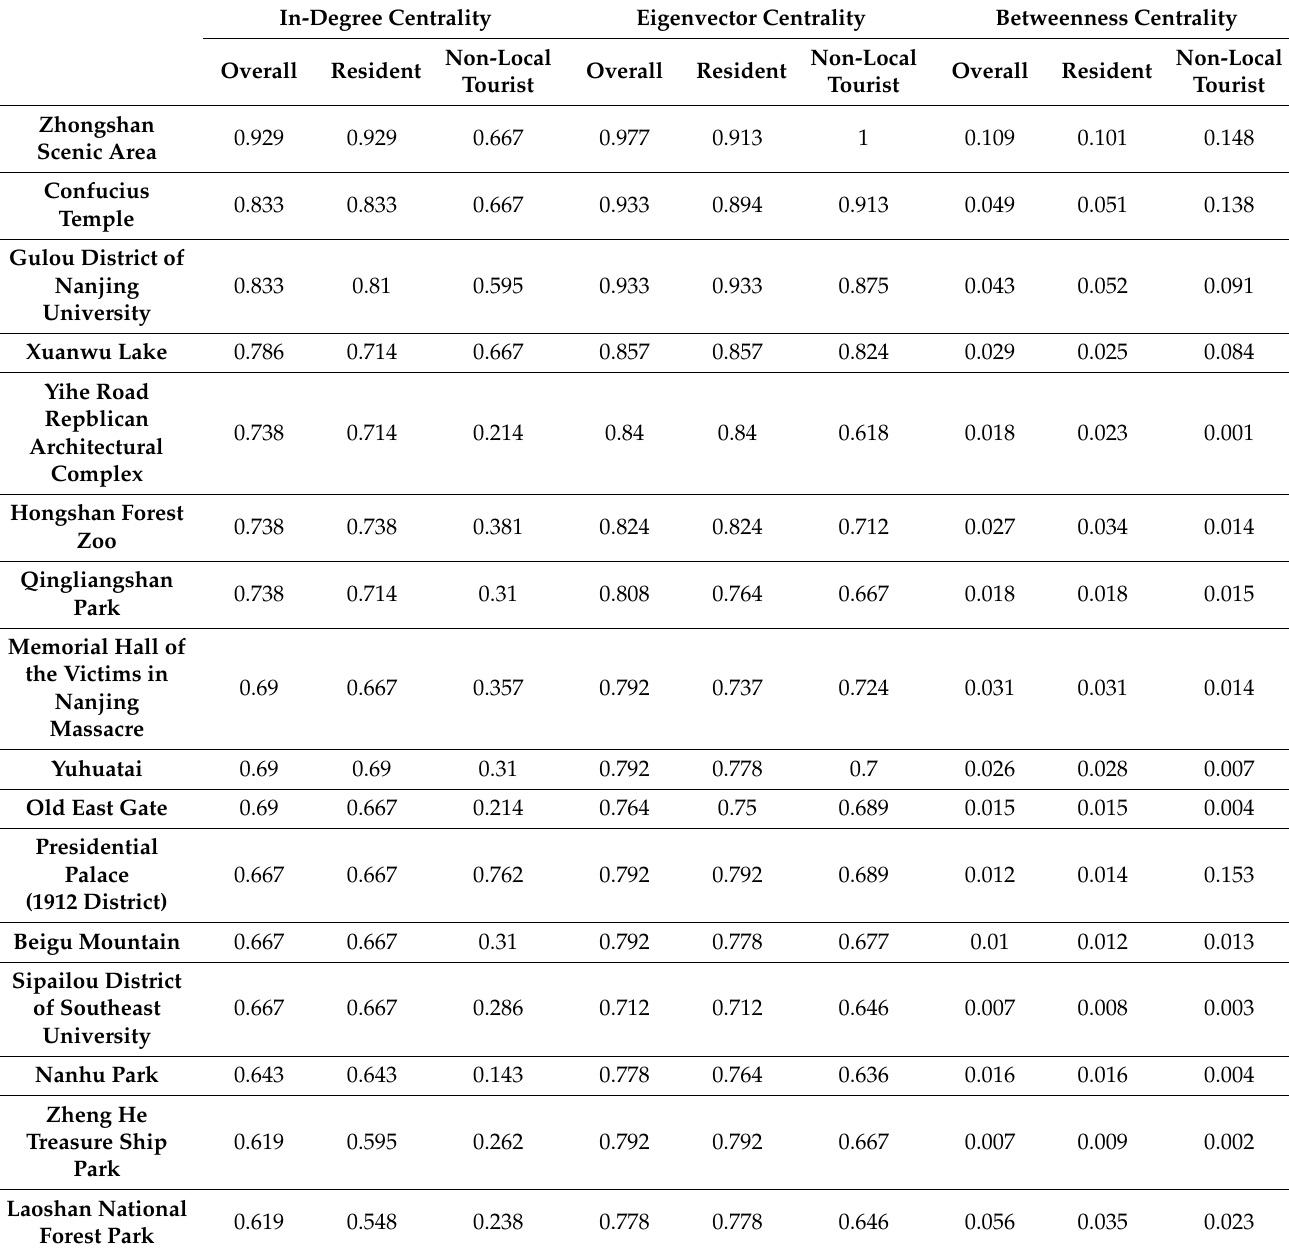
Table 2. Tabulation of three types of node centrality in the tourism flow network. In-Degree Centrality Eigenvector Centrality Betweenness